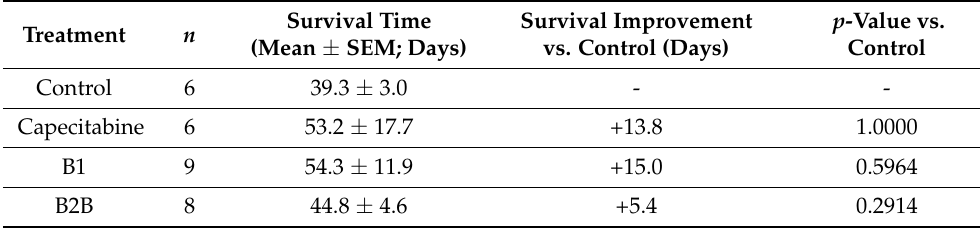
Figure 3. Anticancer activity of diet B1, diet B2B and capecitabine in mice with metastatic colon cancer (CT26.WT murine colon cancer cells inoculated in the tail vein of immunocompetent BALB/c mice; lung metastases model). ( a ) Survival of untreated mice (control), mice treated with oral capecitabine (450 mg/kg/day, 7/7 schedule, 2–3 cycles) and mice treated with diets B1 and B2B for 6 weeks. ( b ) Body weights of mice (mean percentage ± SEM) relative to body weights at the beginning of the treatments (day 4). Table 3. Survival of mice with metastatic colon cancer (lung metastasis model) treated with diet B1, diet B2B and capecitabine.